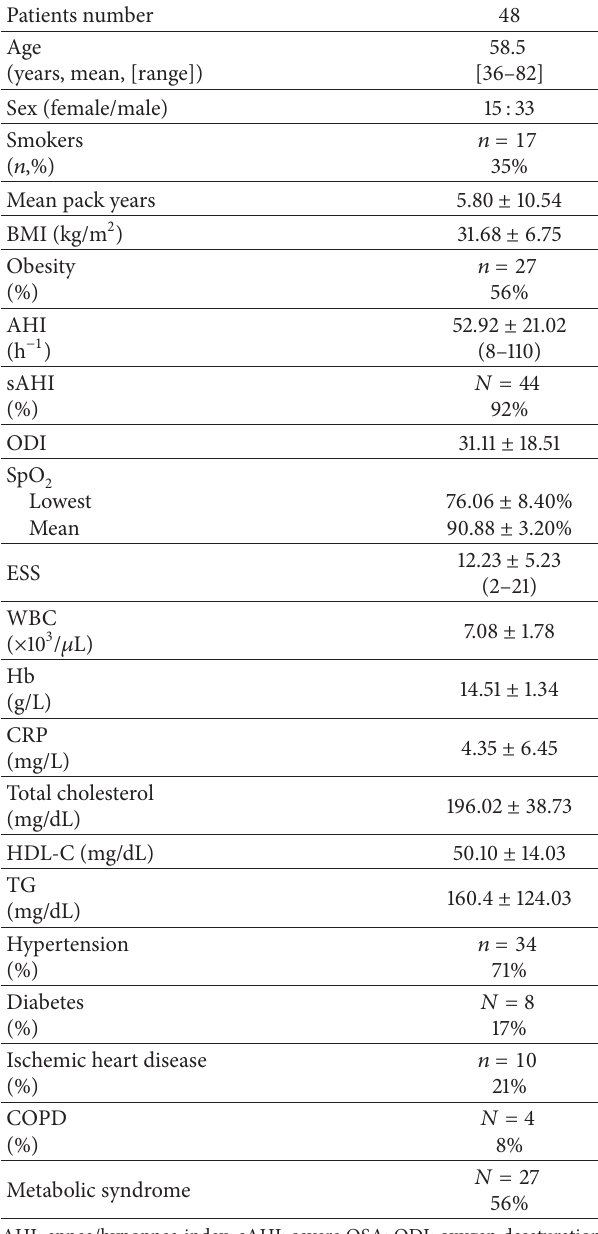
Table 1: Demographic data, results of polysomnographic tests and metabolic characteristic of patients with OSA (data expressed as mean ± SD).